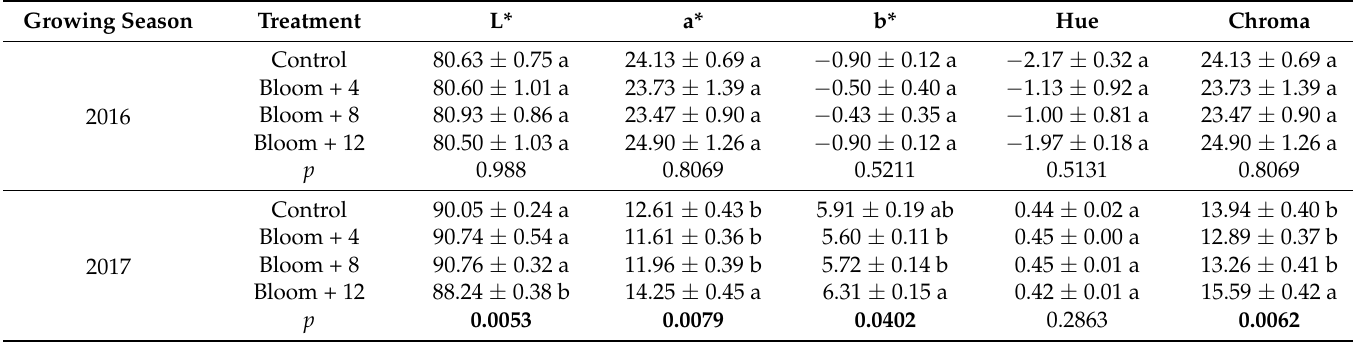
Table A5. Wine chromatic parameters post-malolactic fermentation by treatment and growing season. Treatment means followed by standard error of the mean. Different letters within a column and growing season indicate significant differences between treatment groups for Fisher’s LSD at p < 0.05. p values below 0.05 are shown in bold